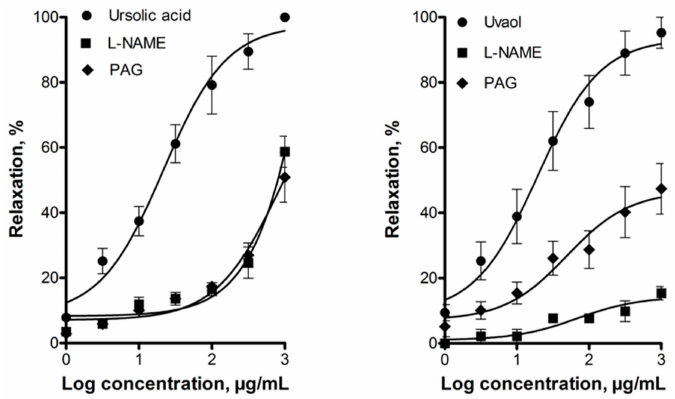
Figure 4. Vasodilatory effect of ursolic acid and uvaol in the absence (control) and presence of inhibitors of enzymes that produce gasotransmitters: NG-nitro- L -arginine methyl ester ( L -NAME; 100 µ M) and DL -propargylglycine (PAG; 10 mM). Analysis by repeated-measures two-way ANOVA was made between the curves of each triterpene in the presence of L -NAME or PAG ( p < 0.001).